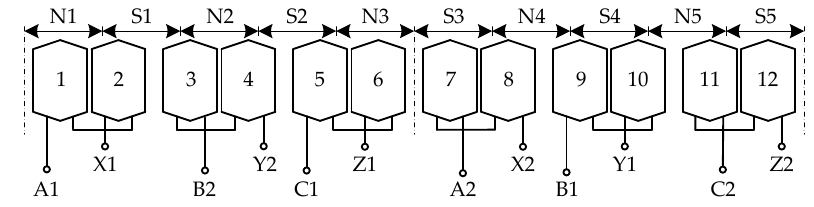
Figure 3. Stator windings outspread diagram of the DRPMSM.